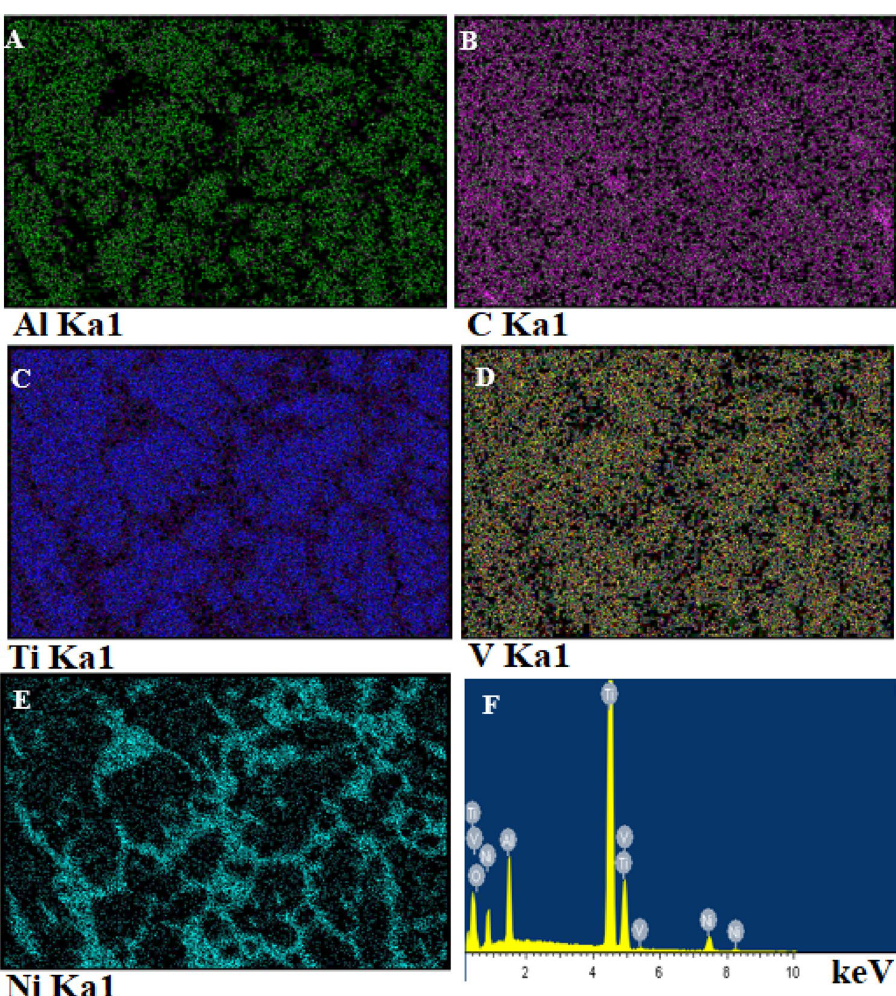
Figure 4. EDS map of treated Ti surface containing 250 nm TiO 2 and 40 nm Al 2 O 3 ( A ) Aluminum ( B ) Carbon ( C ) Titanium ( D ) Vanadium ( E ) Nickel ( F ) EDS spectrum of the treated zone.